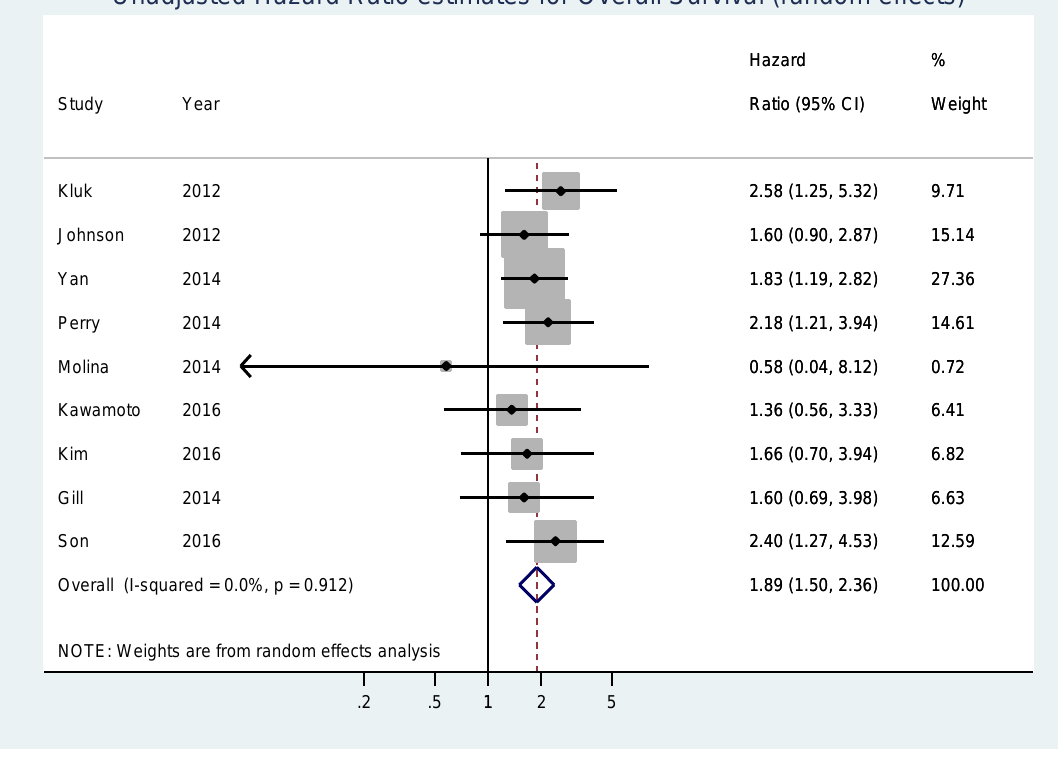
Figure 3. Forest plot showing the meta-analysis of unadjusted hazard ratio estimates for overall survival (OS) in patients with MYC overexpression.